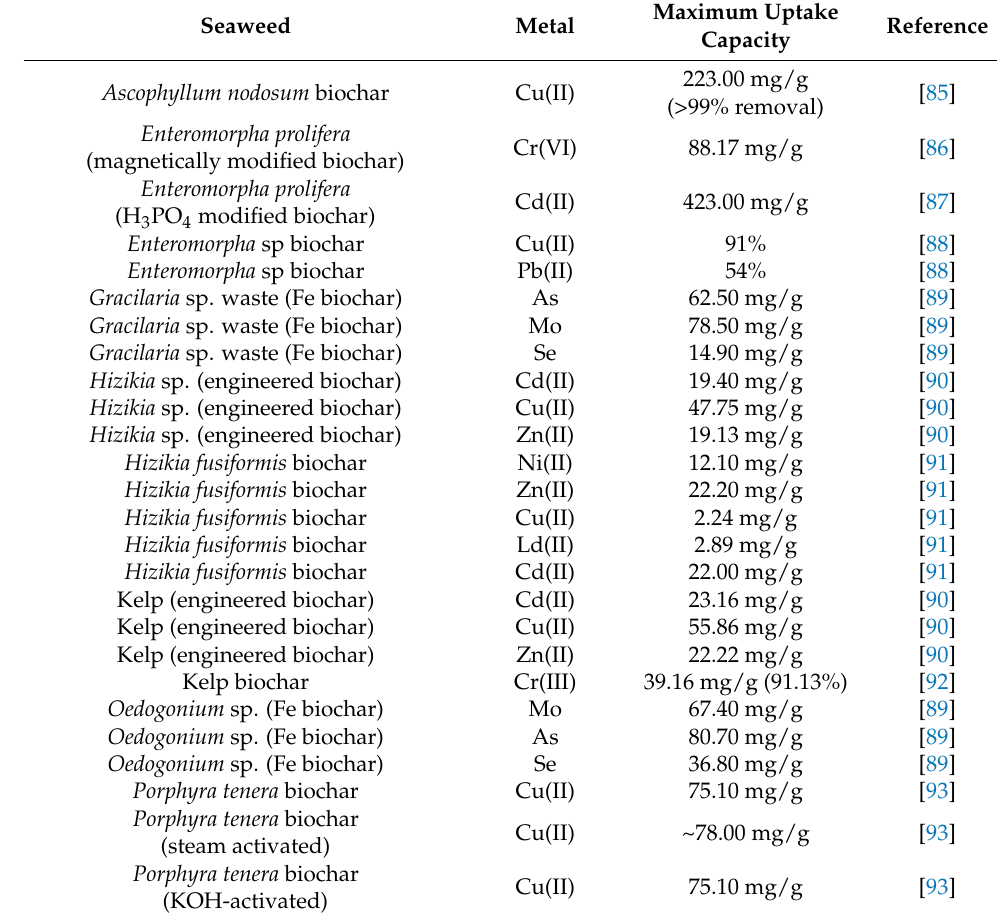
Table 4. Seaweed-derived biochar/carbons for metallic pollutant uptake.